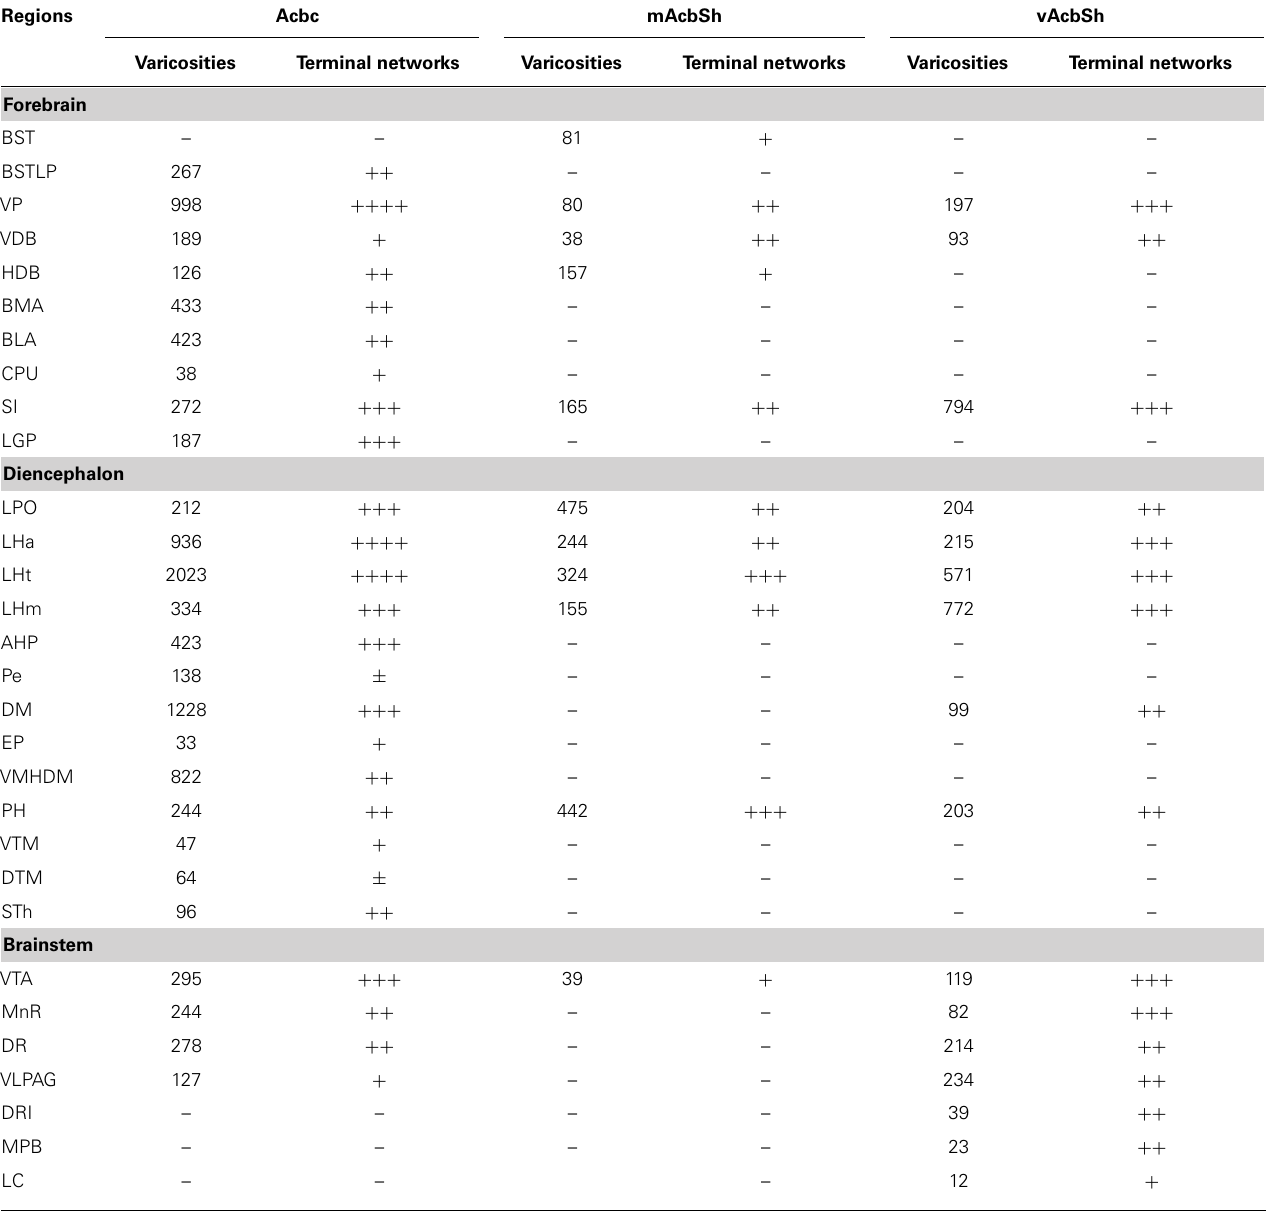
Table 1 | Distribution of hrGFP-positive varicosities and terminal networks followingAAV-lox-Stop-hrGFP injections into theAcbC, mAcbSh, and vAcbSh. 1